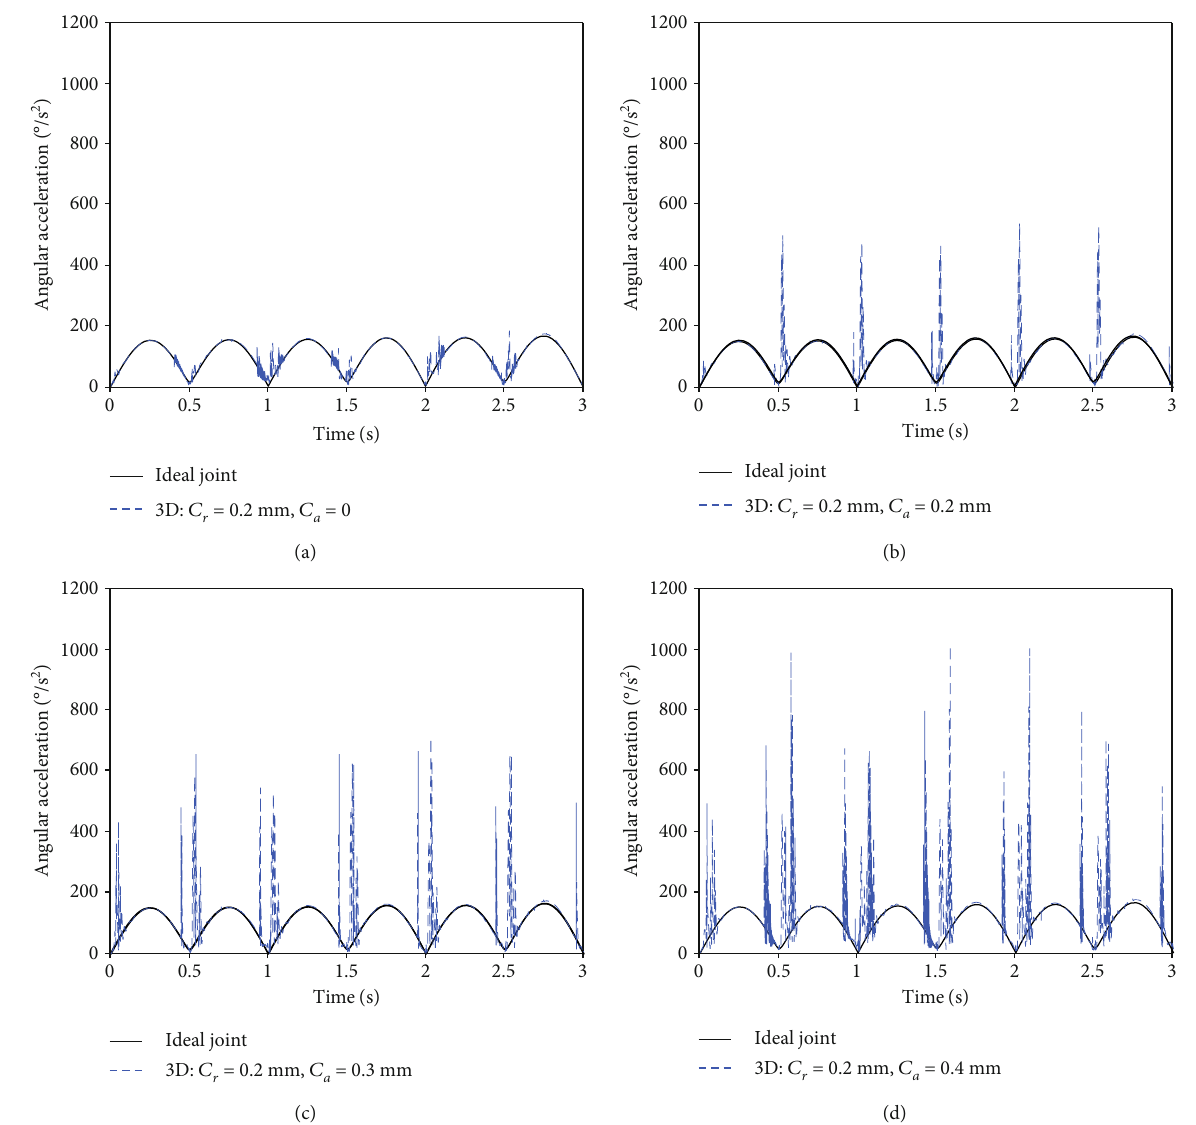
Figure 13: Angular acceleration of antenna: (a) C C = 0 : 2 mm , C r